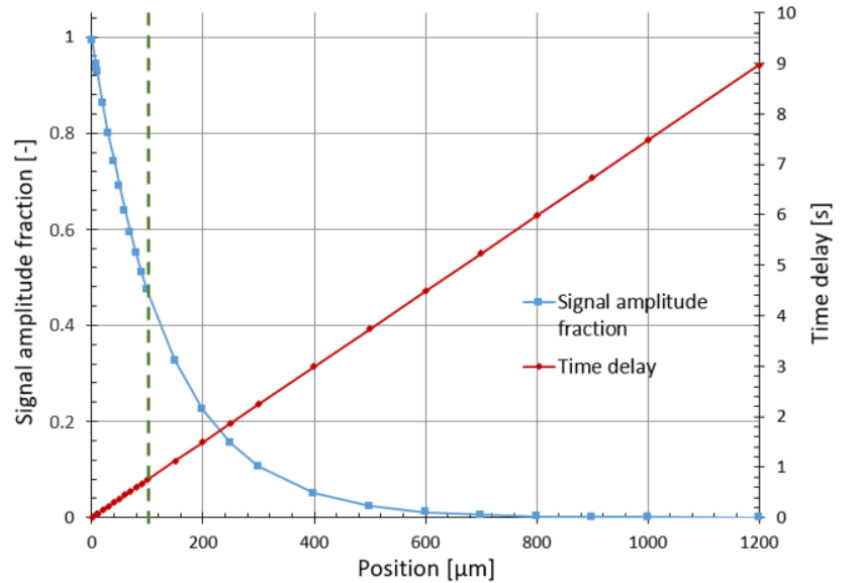
Figure 10. Variation of θ within the plate, the blue curve shows the signal attenuation as a function of the thickness, the red curve shows the time delay on the initial information as a function of the thickness.